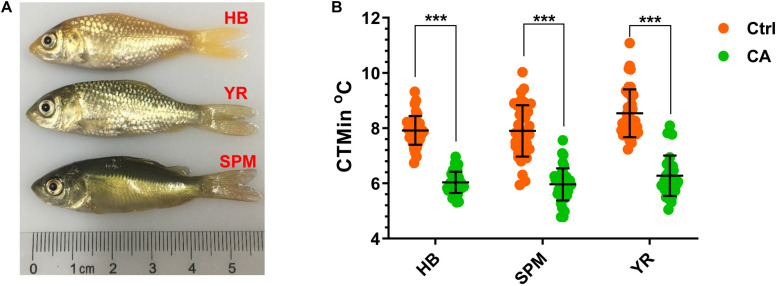
Cold acclimation of the three common carp strains. (A) Photos of the experimental fish. HB, Hebao red carp; YR, Yellow river carp; SPM, Songpu mirror carp. (B) Critical thermal minimums (CTMin) of the control (Ctrl, maintained at 28oC) and the cold-acclimated (CA, exposed to 18oC for 24 h) fish. Individual cases are displayed, the mean and SD of data sets are indicated (n = 50); ***p < 0.001.